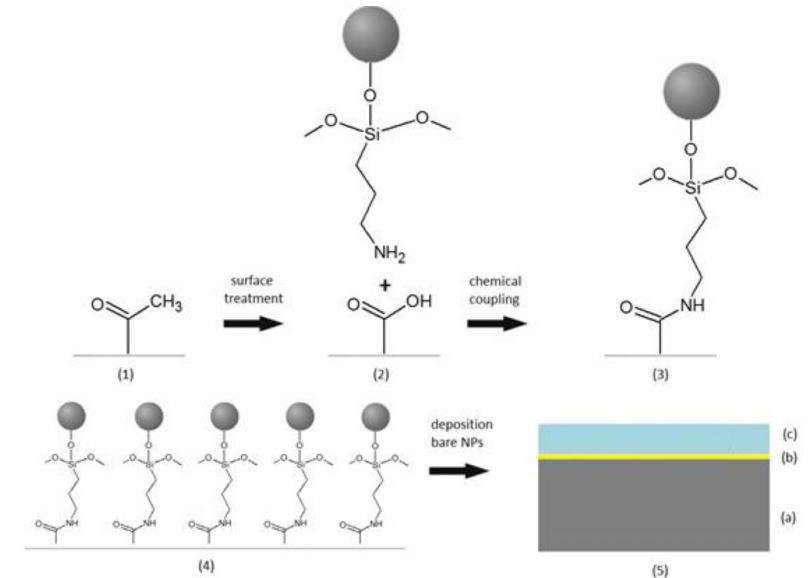
Figure 1. Schematic representation of the steps to obtain a titania thin film on a polymethylmethacrylate (PMMA) substrate: The PMMA substrate ( 1 ) is surface modified to obtain carboxylic acid functionalities ( 2 ); The nanocrystals are coupled to the surface through a chemical reaction between the carboxylic acids and the ligands on the nanocrystals ( 3 ), such that a layer of coupled nanoparticles ( 4 ) is formed; ( 5 ) A second, thicker layer of titania nanoparticles (c) can be deposited on the first layer (b), forming a titania thin film on the polymer substrate